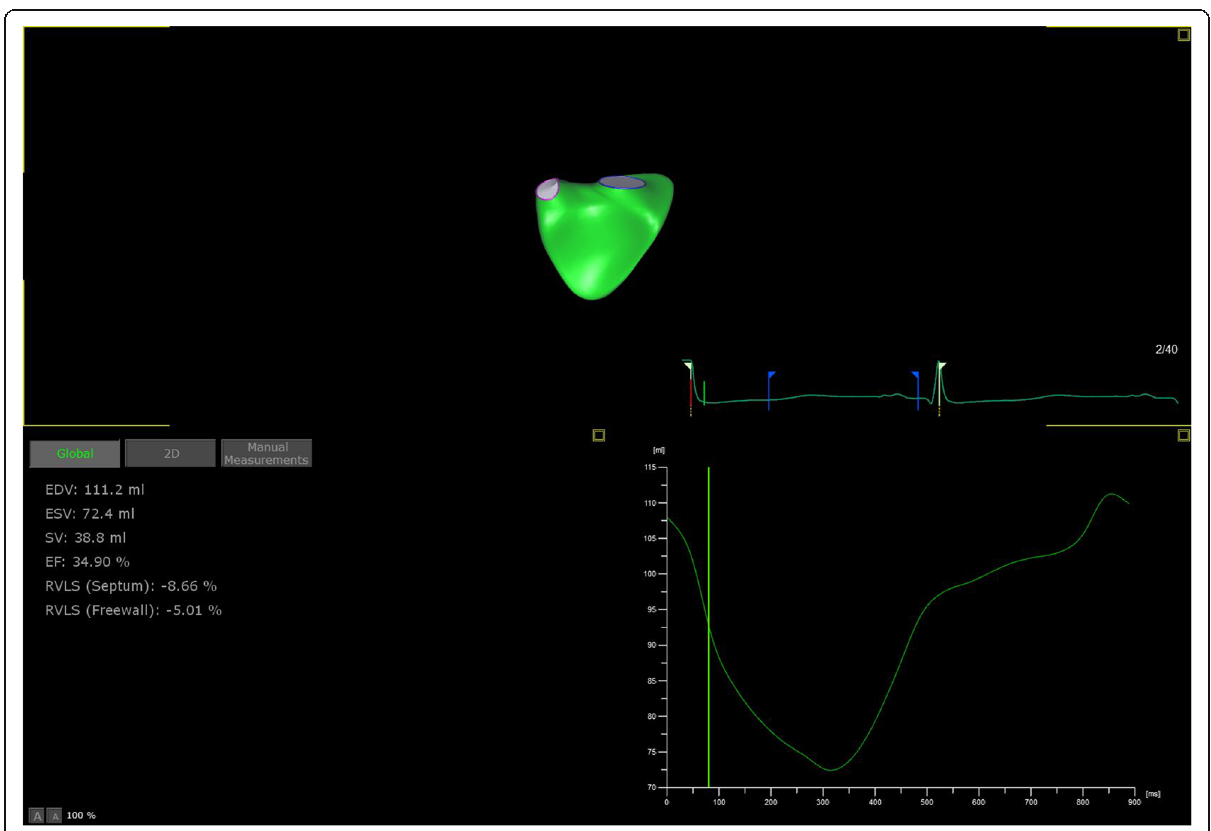
Fig. 2 Three-dimensional right ventricular ejection fraction on postoperative day 28. Right ventricular ejection fraction evaluated by three-dimensional analysis improved to